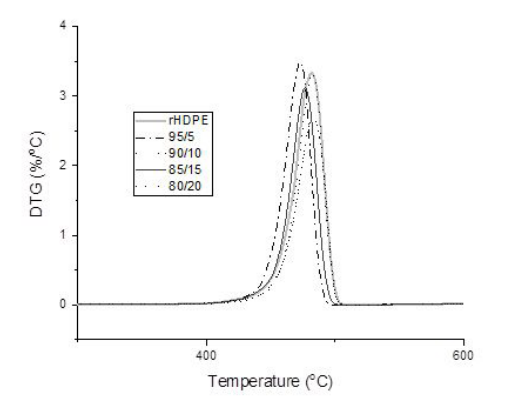
Figure 5. DTG curves of rHDPE/mica formulations